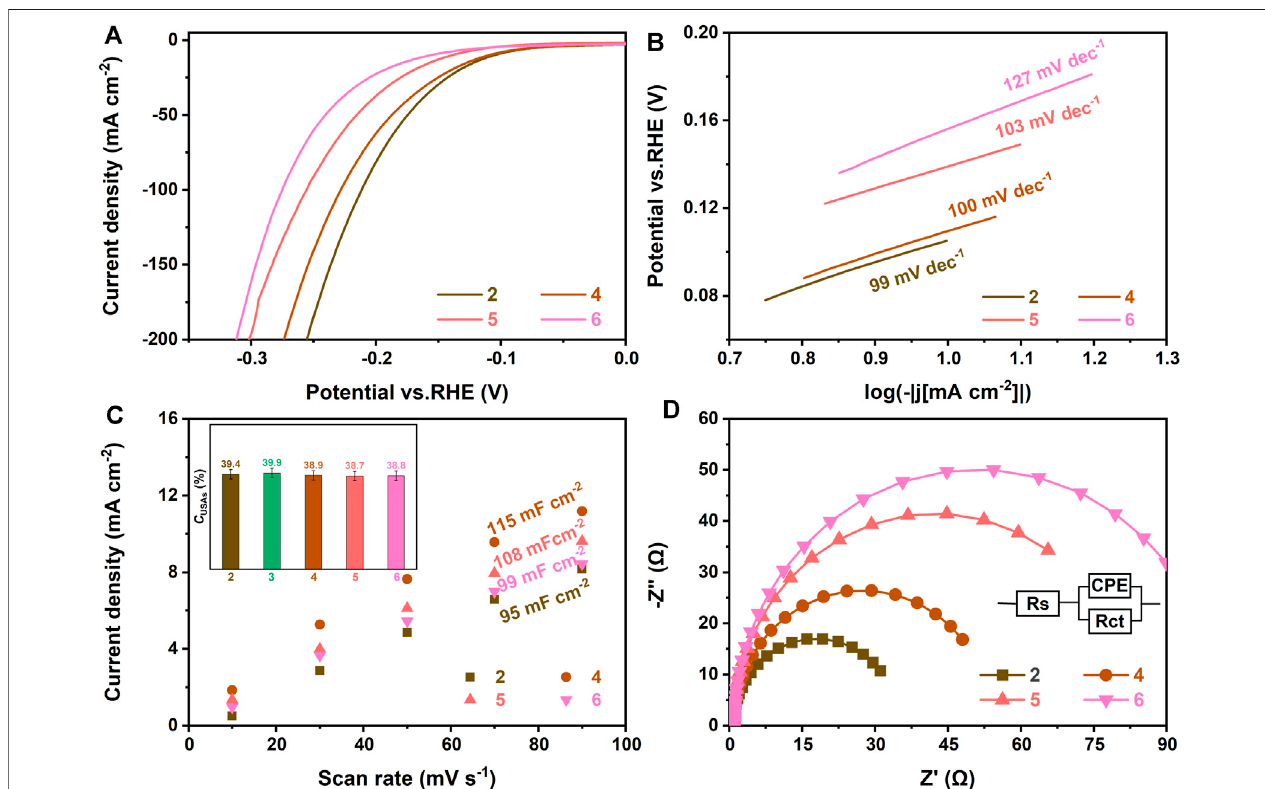
FIGURE 7 | (A) Polarization curves, (B) Tafel plots, (C) C dl at different scan rates, and (D) Nyquist plots of Ru-MoS 2-x -CoS 2 /CC-1.0 (2), Ru-MoS 2-x -CoS 2 /CC-7.0 (4), Ru-MoS 2-x -CoS 2 /CC-10.0 (5), and Ru-MoS 2-x -CoS 2 /CC-30.0 (6). The inset of panel (C) is C USAs of the related samples. The electrolyte is N 2 -saturated 1 M